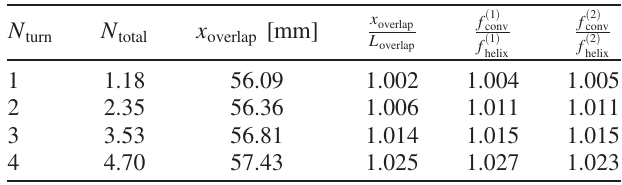
TABLE II. Parameters of the helical beam